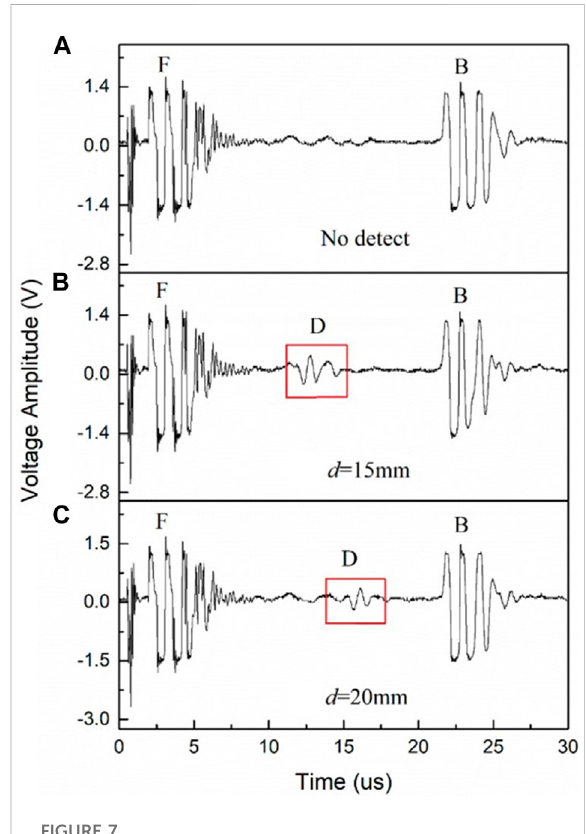
FIGURE 7 Re fl ected ultrasonic waveforms atvoidswith differentdepths d in the specimen (A) No defects, (B) Void with depth d = 15 mm, (C) Void with depth d = 20 mm (Tian et al.,